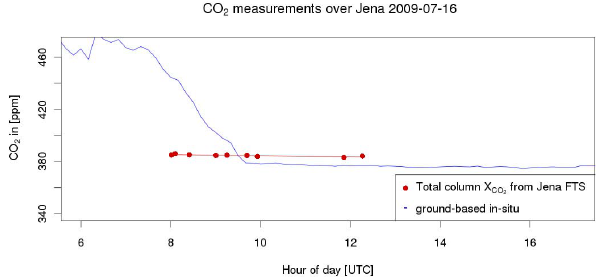
Fig. 14. Diurnal variation of CO 2 from WRF-VPRM for total col- umn and lower levels over Jena. The model resolution is 2km.